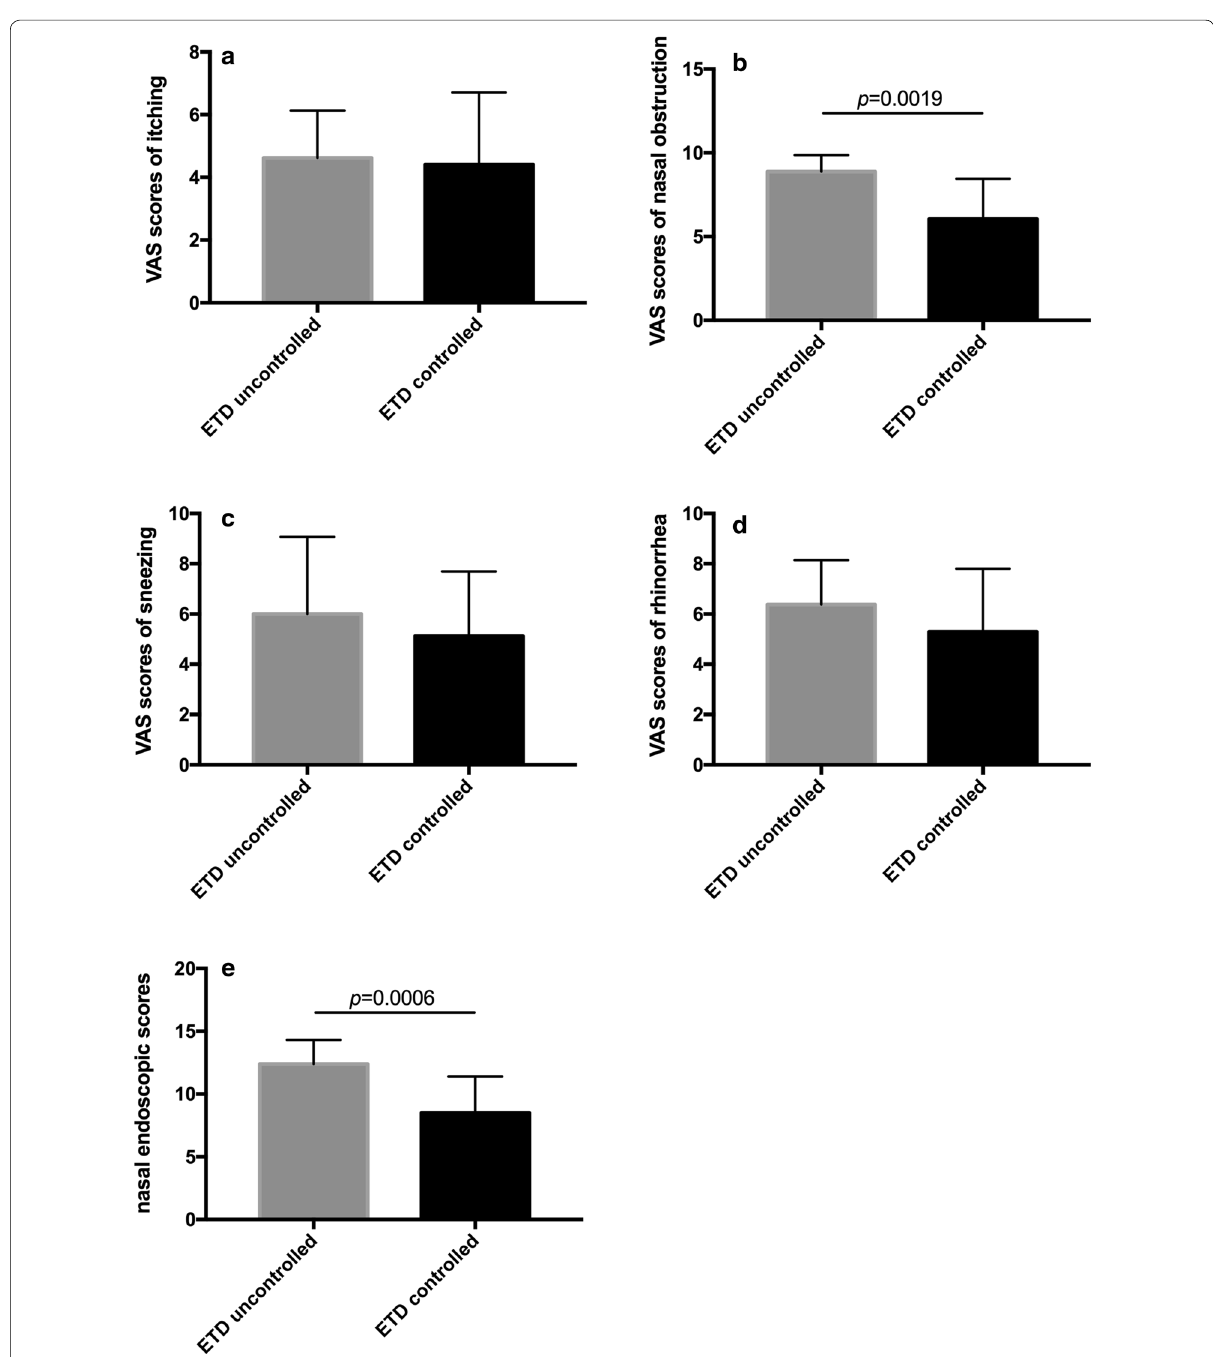
Fig. 4 After 1 month of treatment in HDM-allergic rhinitis patients, improvements in nasal condition affect recovery from eustachian tube dysfunction (ETD). Nasal symptoms of itching ( a ), sneezing ( c ) and rhinorrhoea ( d ) were not significantly different between the controlled-ETD group (ETDQ-7 score < 15 after treatment) and the uncontrolled-ETD group (ETDQ-7 score 15 after treatment). The VAS scores for nasal ≥ obstruction ( b ) and the nasal endoscopic scores ( e ) were higher in the uncontrolled-ETD group than in the controlled-ETD group ( p <